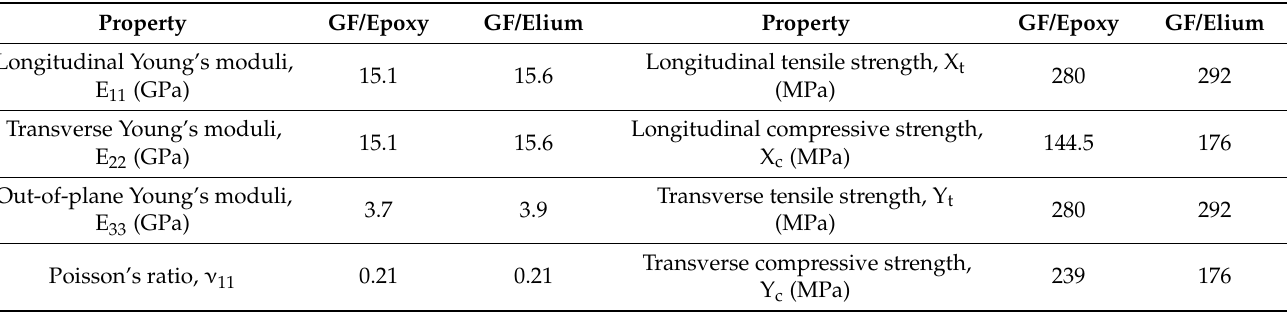
Table 1. The properties of skin material being